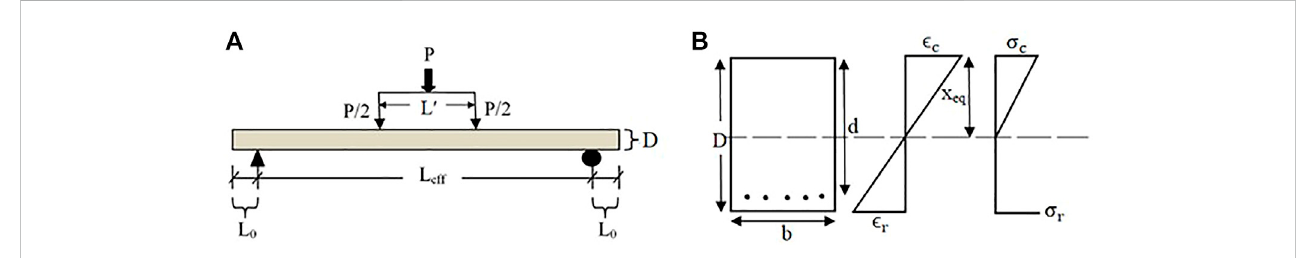
FIGURE 11 (A) Flexural test of slab (B) Cross-sectional stress and strain distribution.